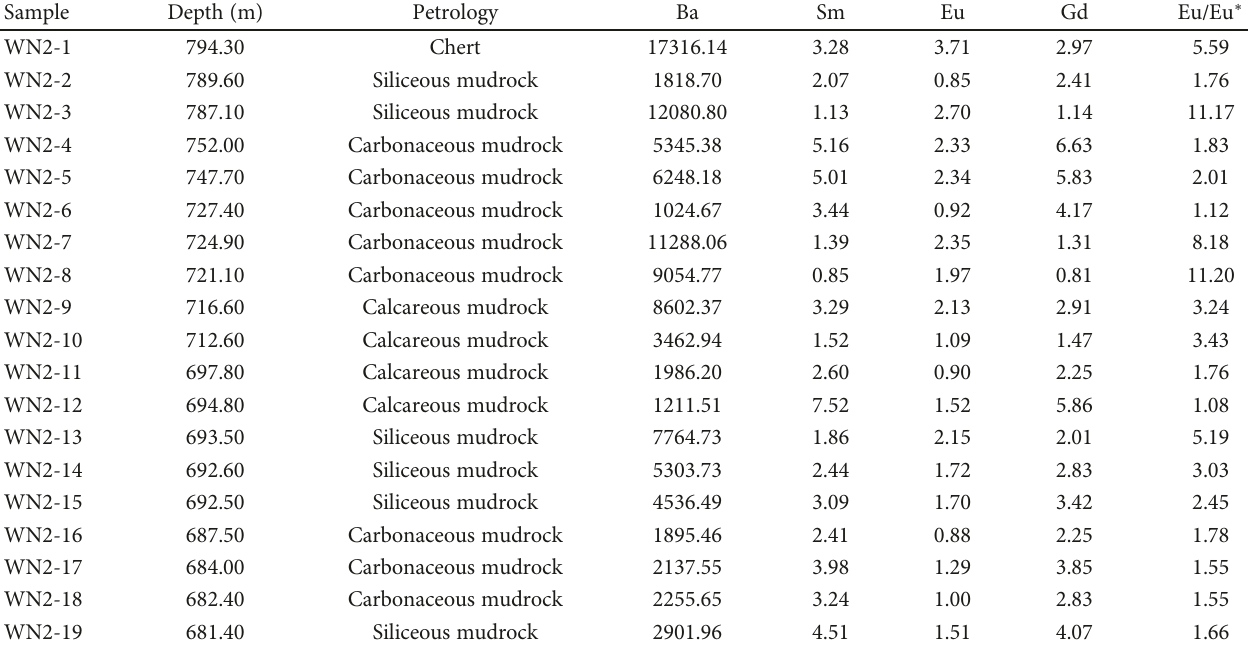
Table 3: Concentrations of REEs and Ba of mudrock and chert samples in Batch 2.